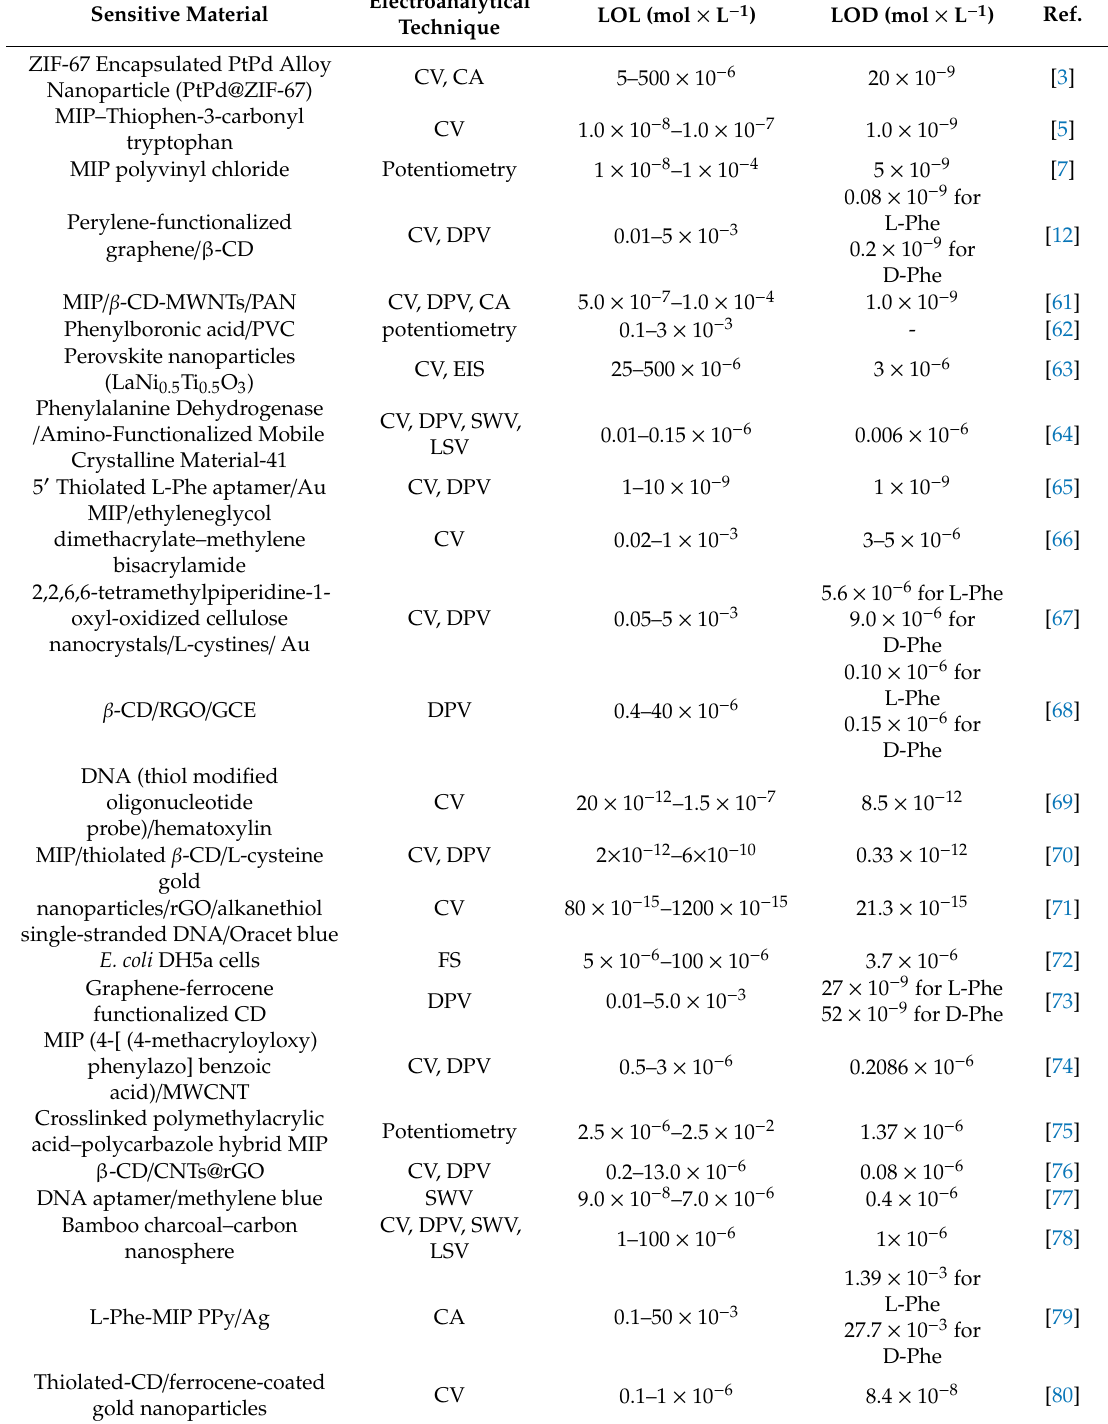
Table 2. Main electrochemical sensors and biosensors used for Phe